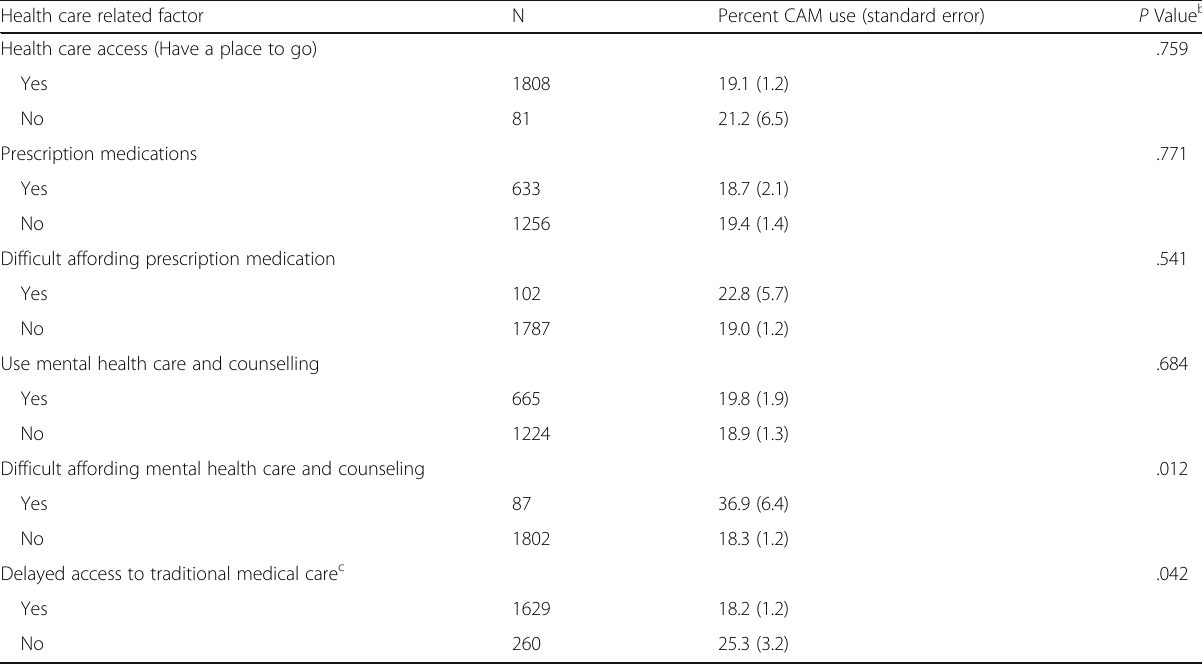
Table 5 Percentage (SE) CAM use a in the last 12 months by health care related factor among n = 1889 children reporting any mental health